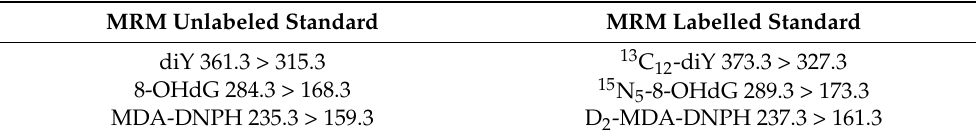
Table 2. MRM mode transitions used for the three urine biomarkers. MRM Unlabeled